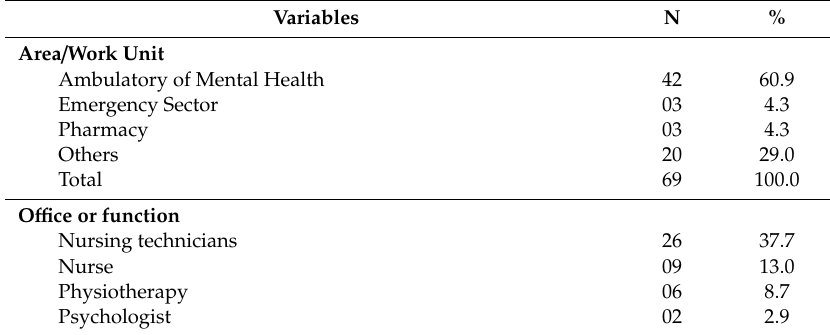
Table 1. Distribution of the profile of health professionals according to HSOPSC variables in the Network of Psychosocial Care of the Municipality of Rio Branco,